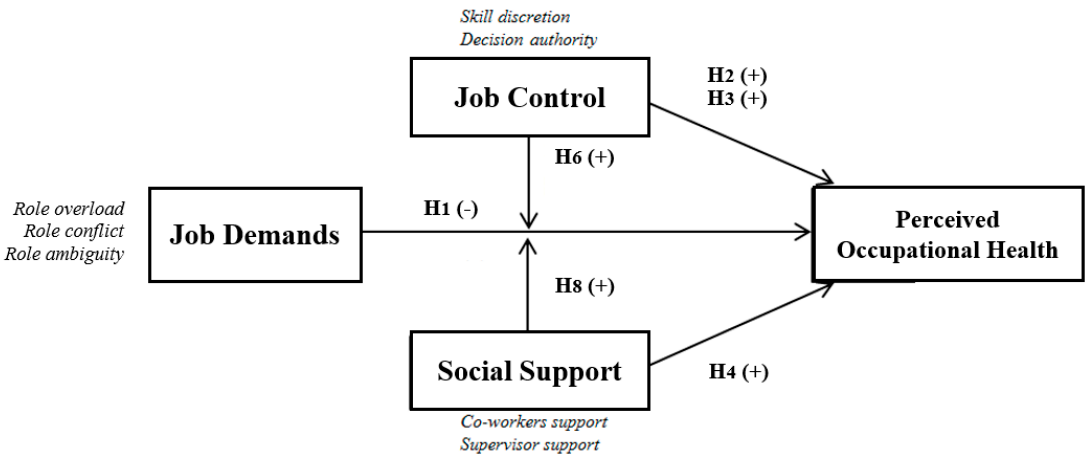
Figure 3. Model hypotheses confirmed.